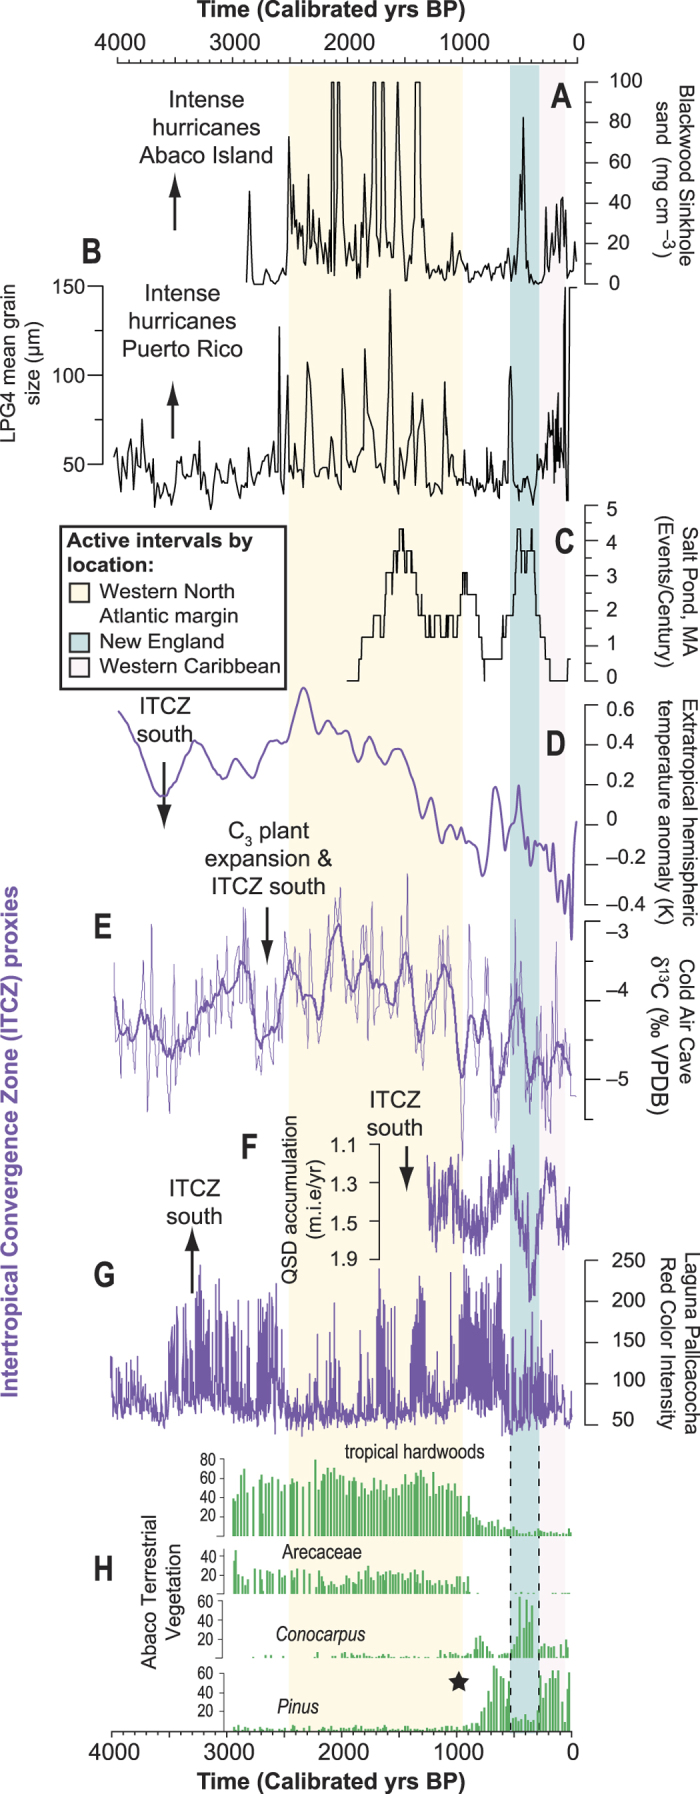
(A) Sand deposition into Blackwood Sinkhole from BLWD-C2, note that the vertical scale is truncated, (B) intense hurricane overwash deposits, Puerto Rico8, (C) Intense hurricane events at Salt Pond, Massachusetts9, (D) Northern-to-Southern hemisphere temperature anomaly333, (E) Raw (light purple) and 100-pt mean (dark purple) of δ13C measurements from speleothem T7 from Cold Air Cave, South Africa35, (F) Quelccaya Ice Cap accumulation rate, Peru43, (G) Laguna Pallcacocha red color intensity provides evidence for periods of increased intense precipitation, Ecuador36, (H) pollen-based evidence for vegetation changes on Great Abaco Island. Star denotes oldest radiocarbon dated human remains yet recovered from northern Bahamas52. Zero on the horizontal axis is 2000 CE.